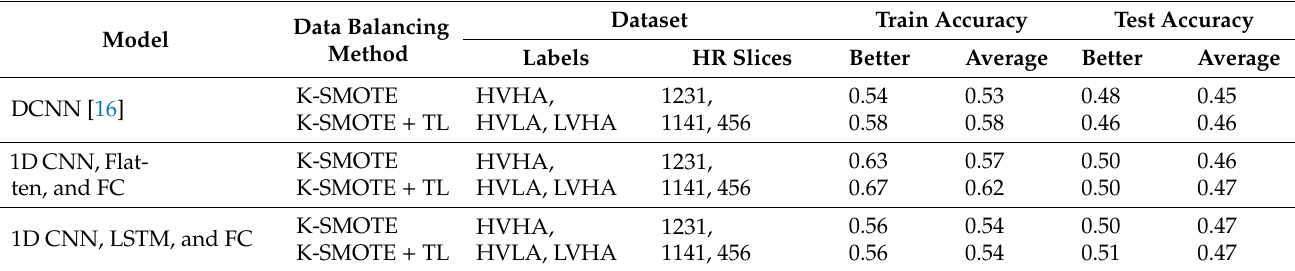
Table 5. ES dataset performance with CNN-based ER models and three-class balancing methods.